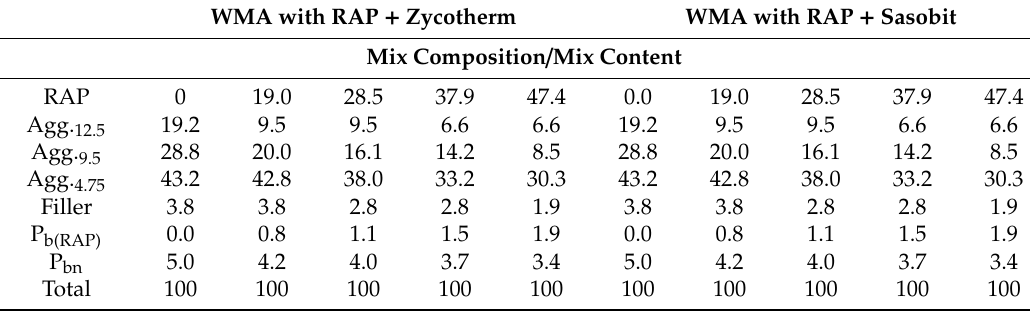
Table 4. Composition and properties of di ff erent